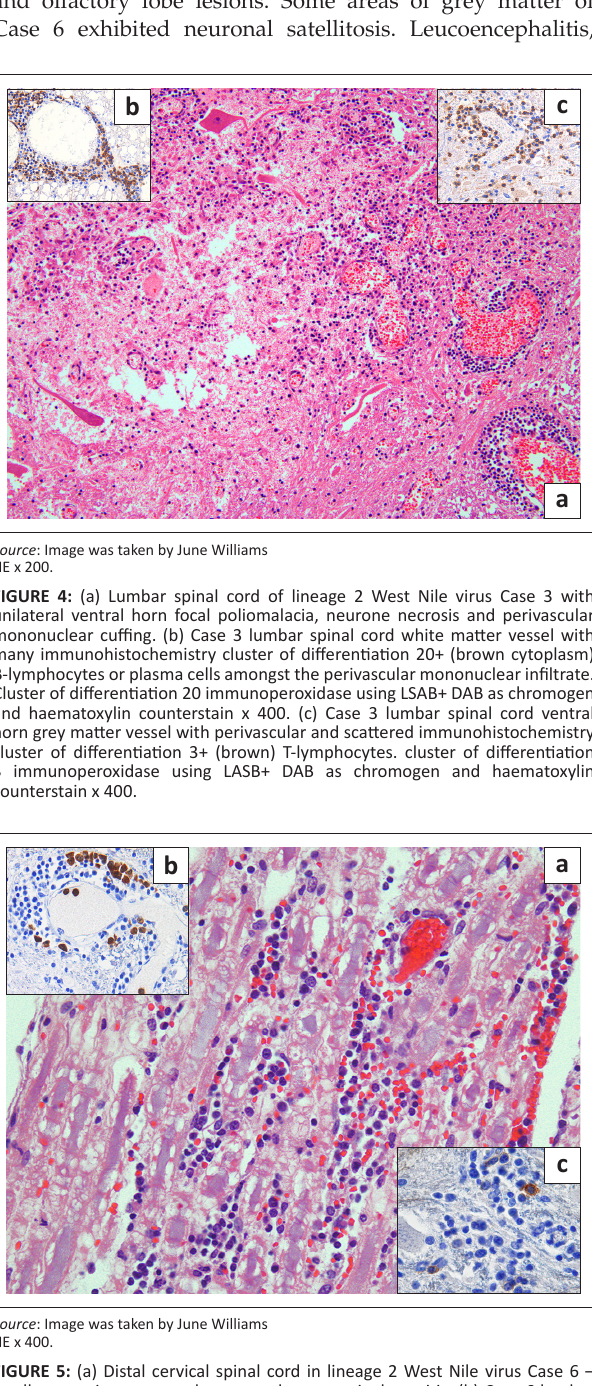
FIGURE 5: (a) Distal cervical spinal cord in lineage 2 West Nile virus Case 6 – locally-extensive mononuclear ventral motor spinal neuritis. (b) Case 6 lumbar spinal cord ventral horn grey matter with perivascular Macrophage 387+ (brown) labelled monocyte-macrophages and some neutrophils. Macrophage 387 immunoperoxidase using LSAB+ DAB as chromogen and haematoxylin counterstain x 400. (c) Case 6 lumbar cord grey matter cluster of differentiation 20+ (brown) labelled B-lymphocytes or plasma cells in grey matter. Cluster of differentiation 20 immunoperoxidase using LSAB+ DAB as chromogen and haematoxylin counterstain x